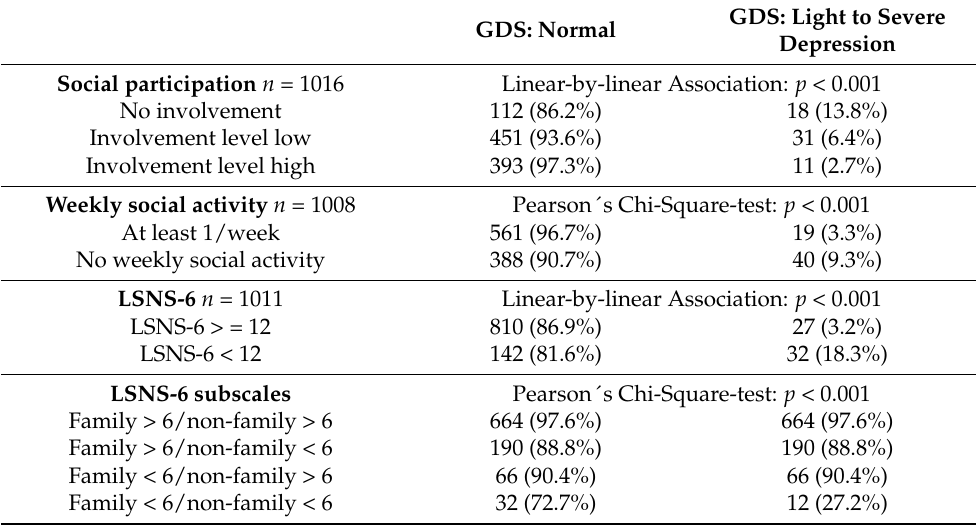
Table 3. Associations of social network, activity, and participation with depressive